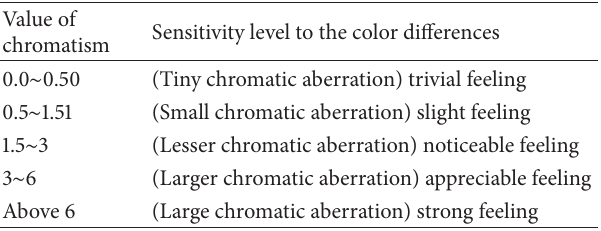
Table 1: Value of chromatism and sensitivity level to the color